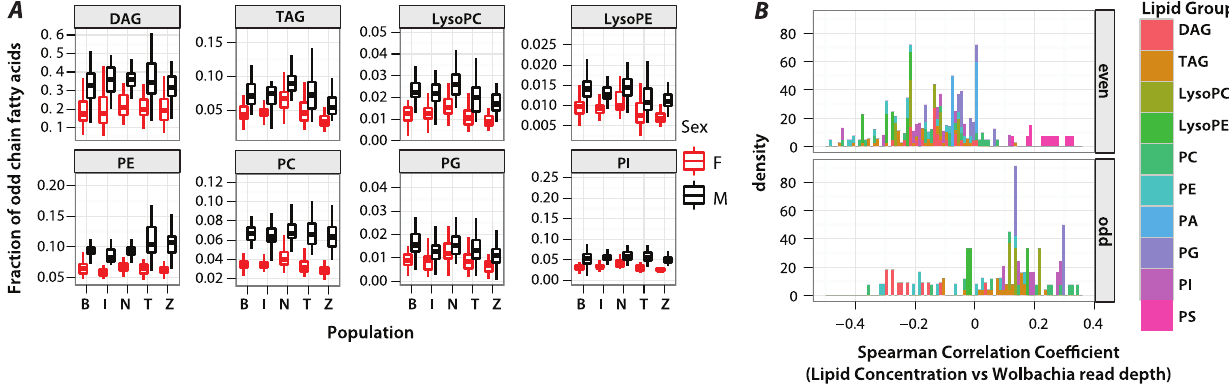
Figure 4. Odd-chain lipid concentration correlates with Wolbachia abundance. A: Fraction of odd-chained FAs estimated from the total carbon count per lipid species. Only lipid classes containing odd length FAs are included. B: Histogram of lipid species concentration correlation with normalized Wolbachia genome read depth (Spearman) for each fly line where Wolbachia was detected ( n =65). Lipid species are color-coded by lipid group and split by FA length categorized into odd and even.